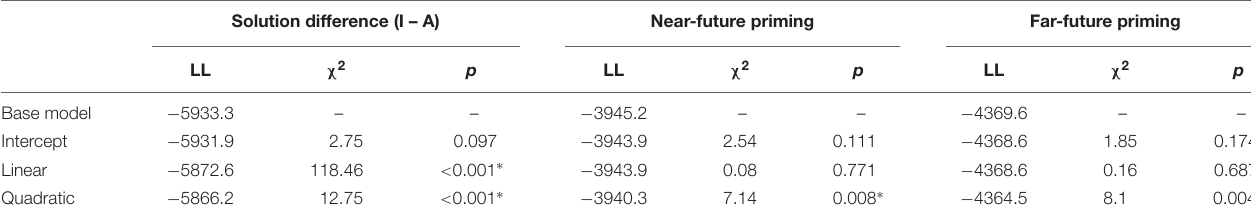
TABLE 2 | Model fit results for each